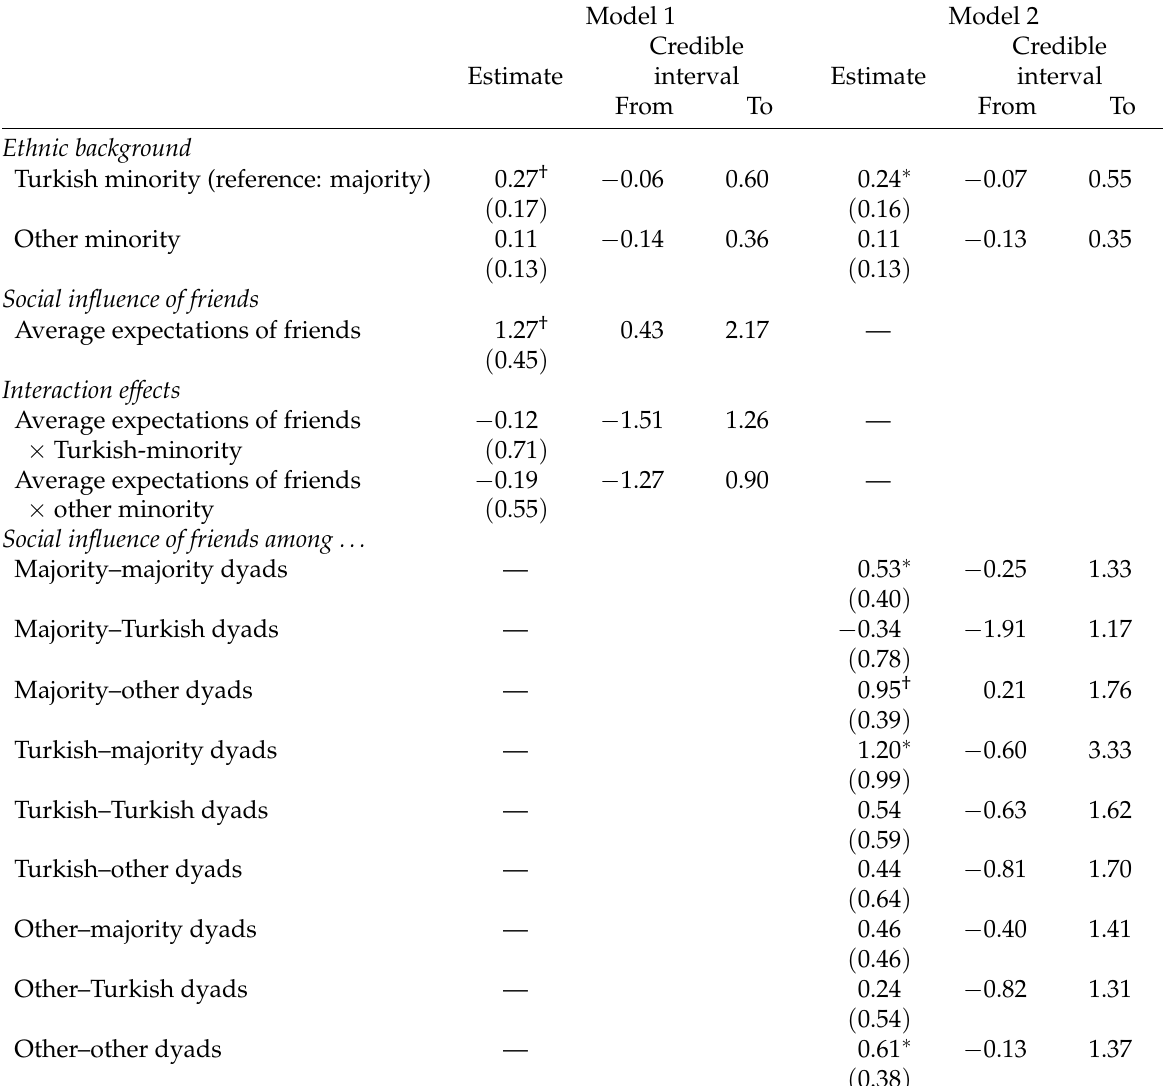
Table 3: Ethnic variation in the social influence of friends estimated through multilevel SAOMs.